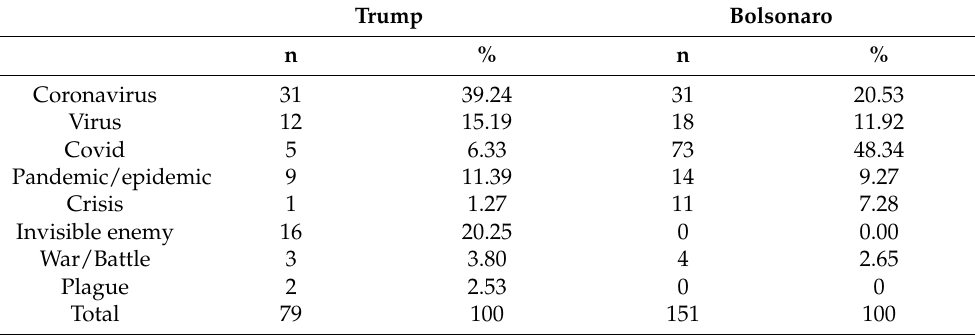
Table 1. Explicit references to the Coronavirus pandemic in Donald Trump’s and Jair Bolsonaro’s Twitter discourses.